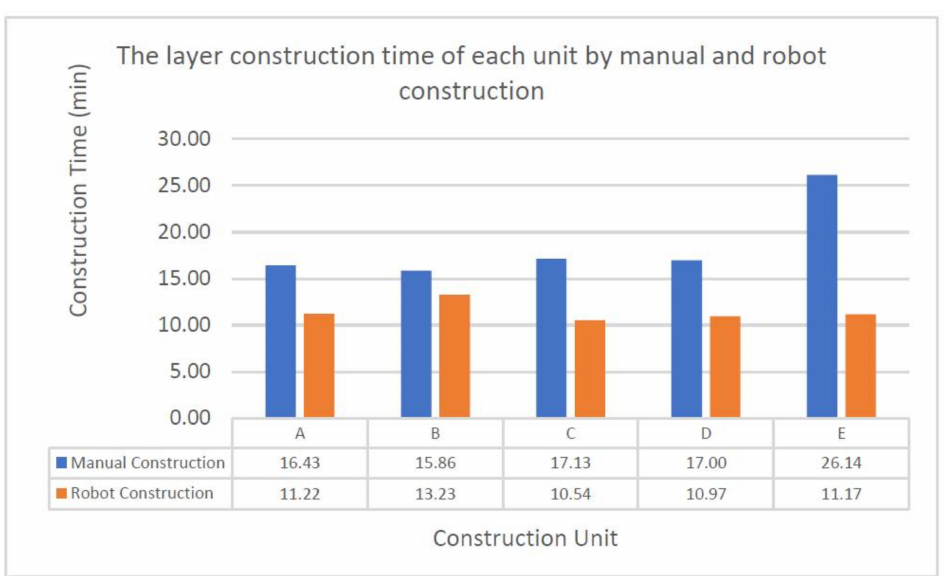
Figure 14. The layer construction time of each unit by robot construction.